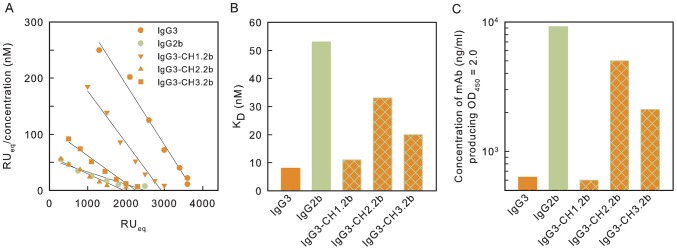
Binding behavior of parental and heavy-chain domain hybrid mAbs.A – Scatchard plots for determination of affinities from equilibrium binding by SPR. B – Dissociation constants (KD in nM) for each mAb calculated from Panel A. C - Binding by ELISA. Results are reported as the concentration of each mAb (ng/ml) that produced an OD450 = 2.0 in a standard ELISA format.